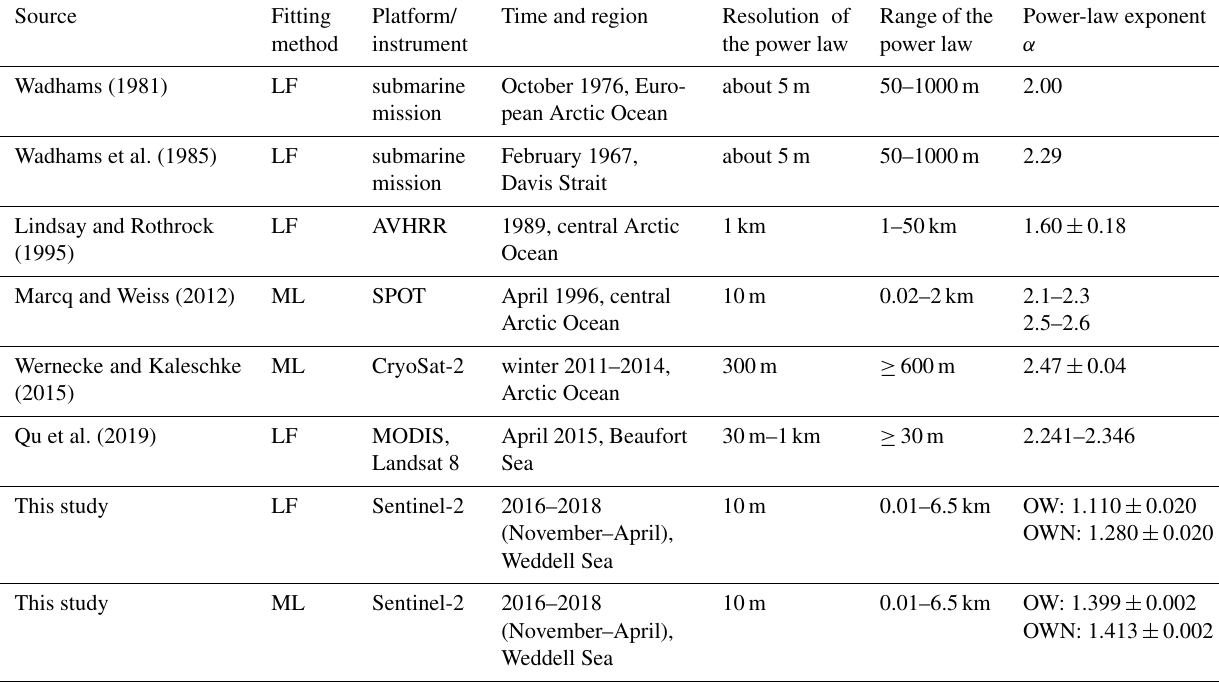
Table 3. Different results from the literature and this study for the Weddell Sea sorted by publishing date. The threshold definition for lead identification differs between the studies. Marcq and Weiss (2012) use two different luminance thresholds. The last two entries are the results of this study for the Weddell Sea for which two thresholds (OW, open-water-covered leads; OWN, open-water-covered and nilas-covered leads) are also applied. The LF method stands for a linear fit, and the ML method stays for the method after Clauset et al. (2009). A detailed explanation of the methods is in Sect.